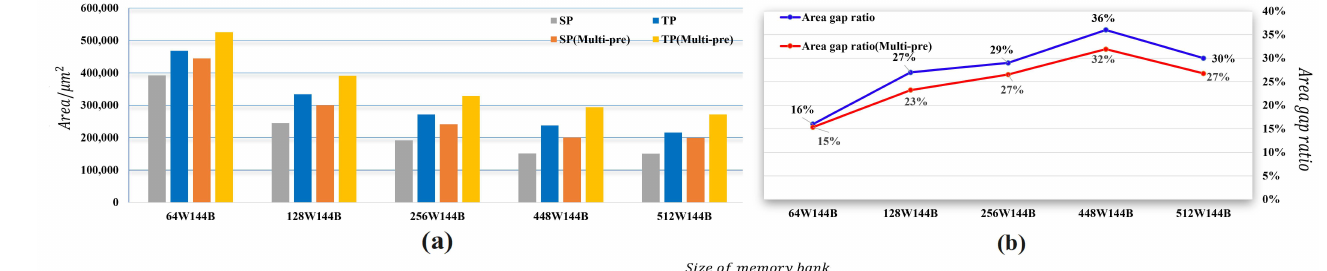
Figure 11. The difference between SPM and TPM at different depths: ( a ) the space cost; ( b ) the trend of the area